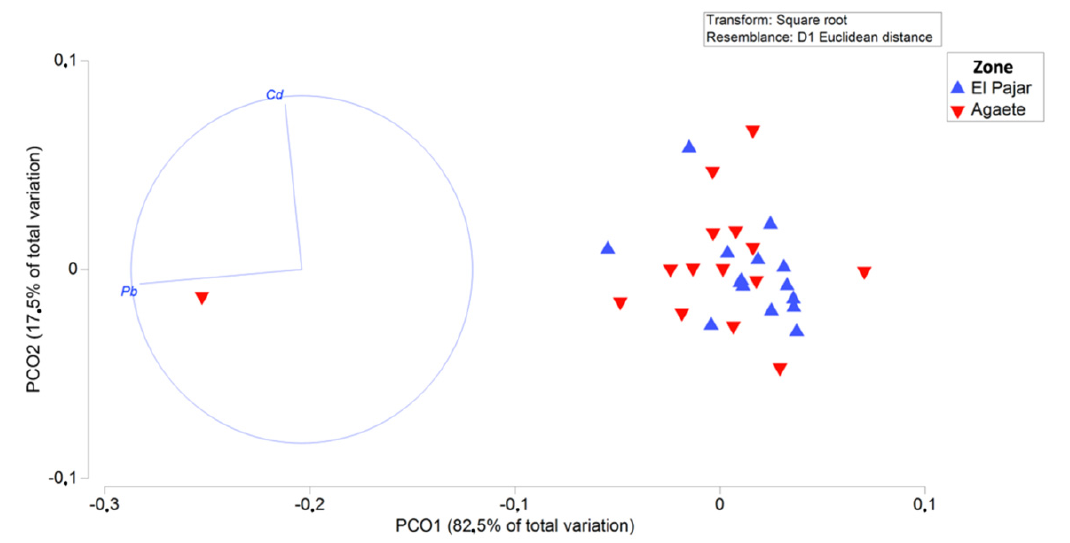
Figure 4. Principal Coordinate Analysis (PCoA) of muscle tissue with the location factor.